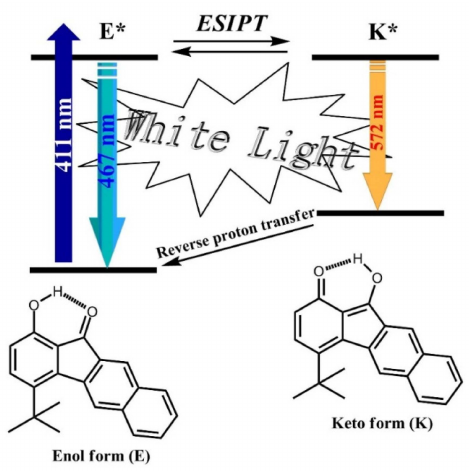
Figure 6. Schematic representation of the white-light generation process in 1 . ESIPT: excited-state intramolecular proton transfer.